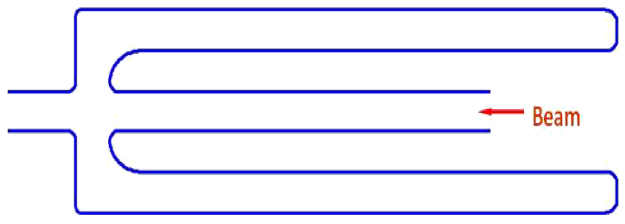
without the coupler and dampers.